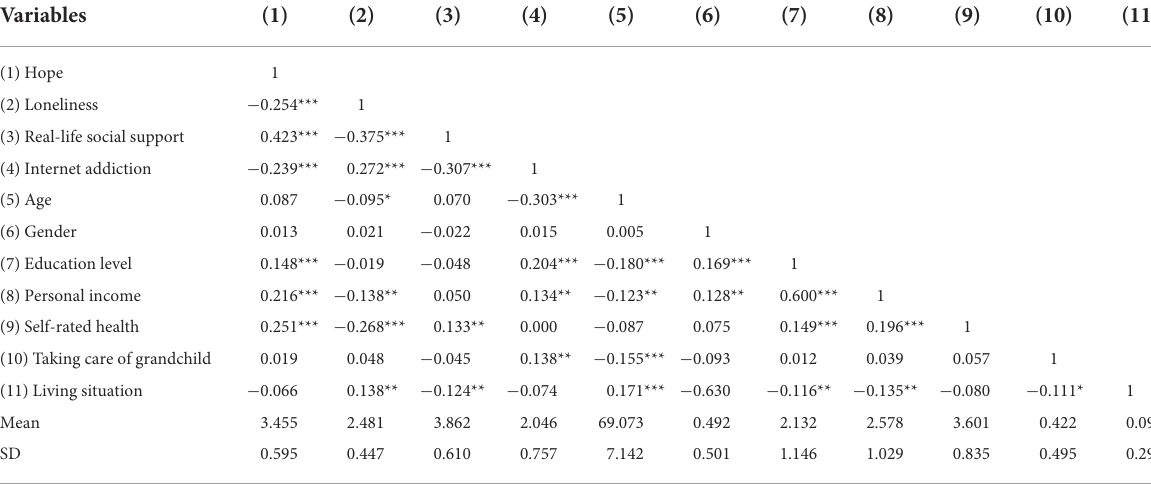
TABLE 2 Descriptive and correlations among all variables.